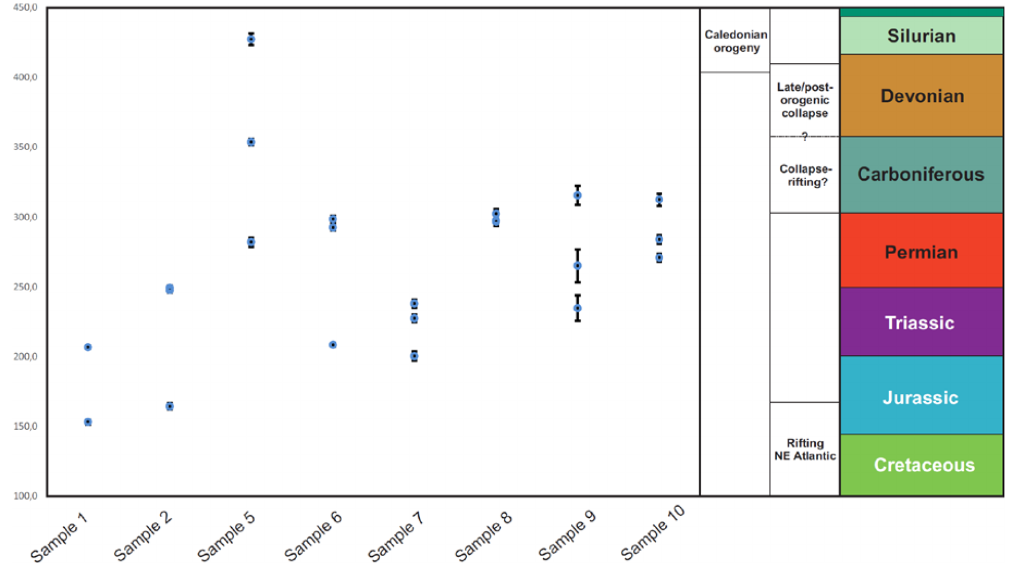
Figure 6. Graph showing the Phanerozoic K–Ar ages and associated error obtained for fault gouge samples in NW Finnmark. The vertical axis represents time in Ma and the horizontal axis shows the dated sample numbers, whose locations are displayed in Figs. 1 and 4. Columns to the right of the graph display major contractional (based on Ramberg et al., 2008; Vetti 2008; Corfu et al., 2014) and extensional events (Faleide et al., 1993; Steltenpohl et al., 2011; Koehl et al., 2018a) that affected north Norway in late Paleozoic–Mesozoic times, and associated geological time